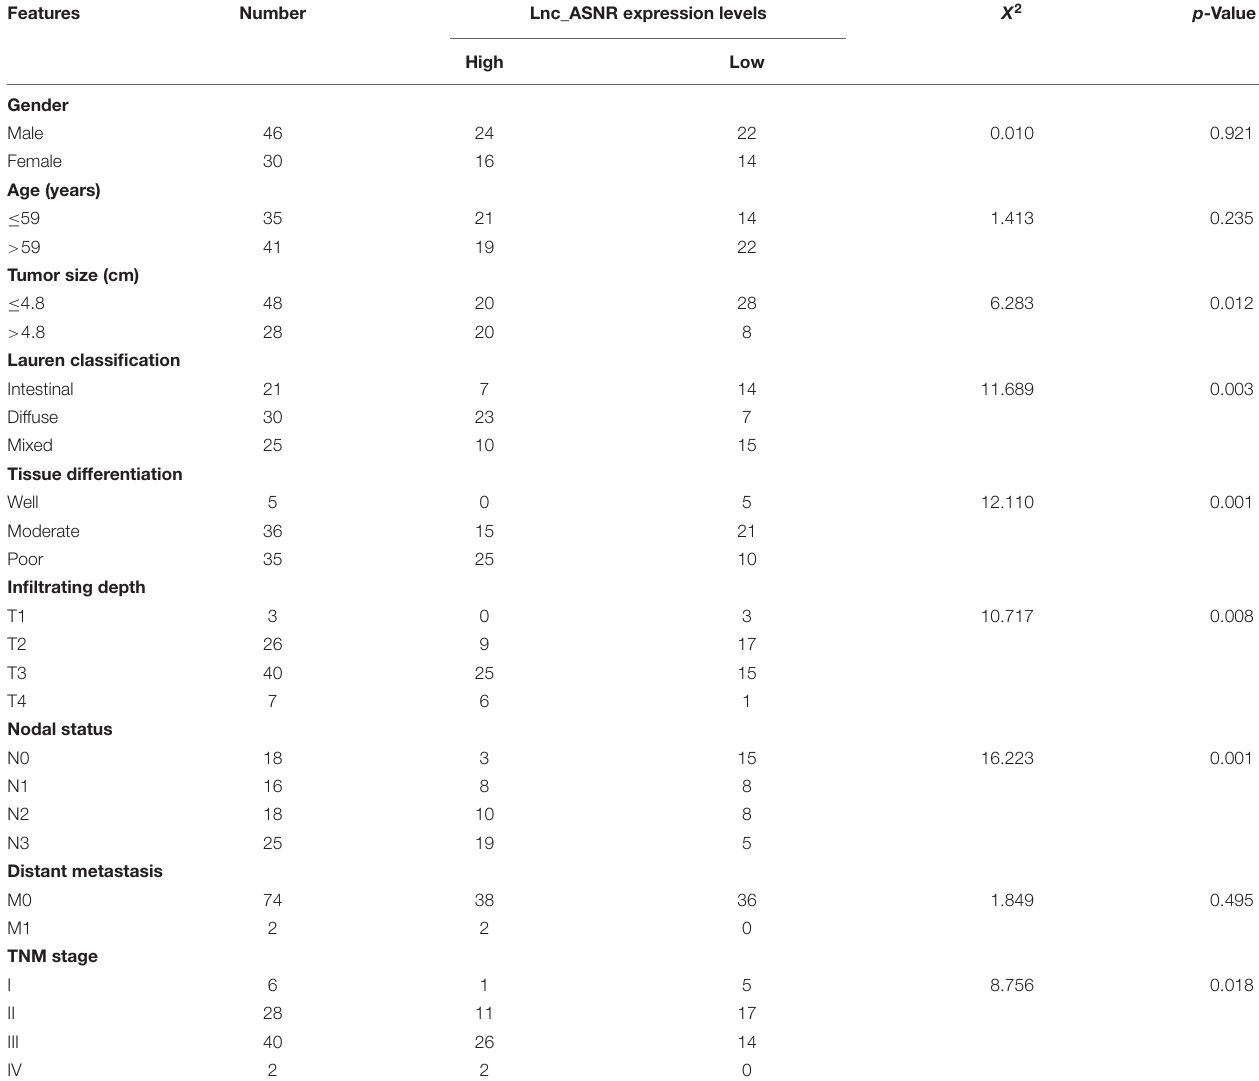
TABLE 1 | Association of Lnc_ASNR expression with clinicopathological features of gastric cancer.